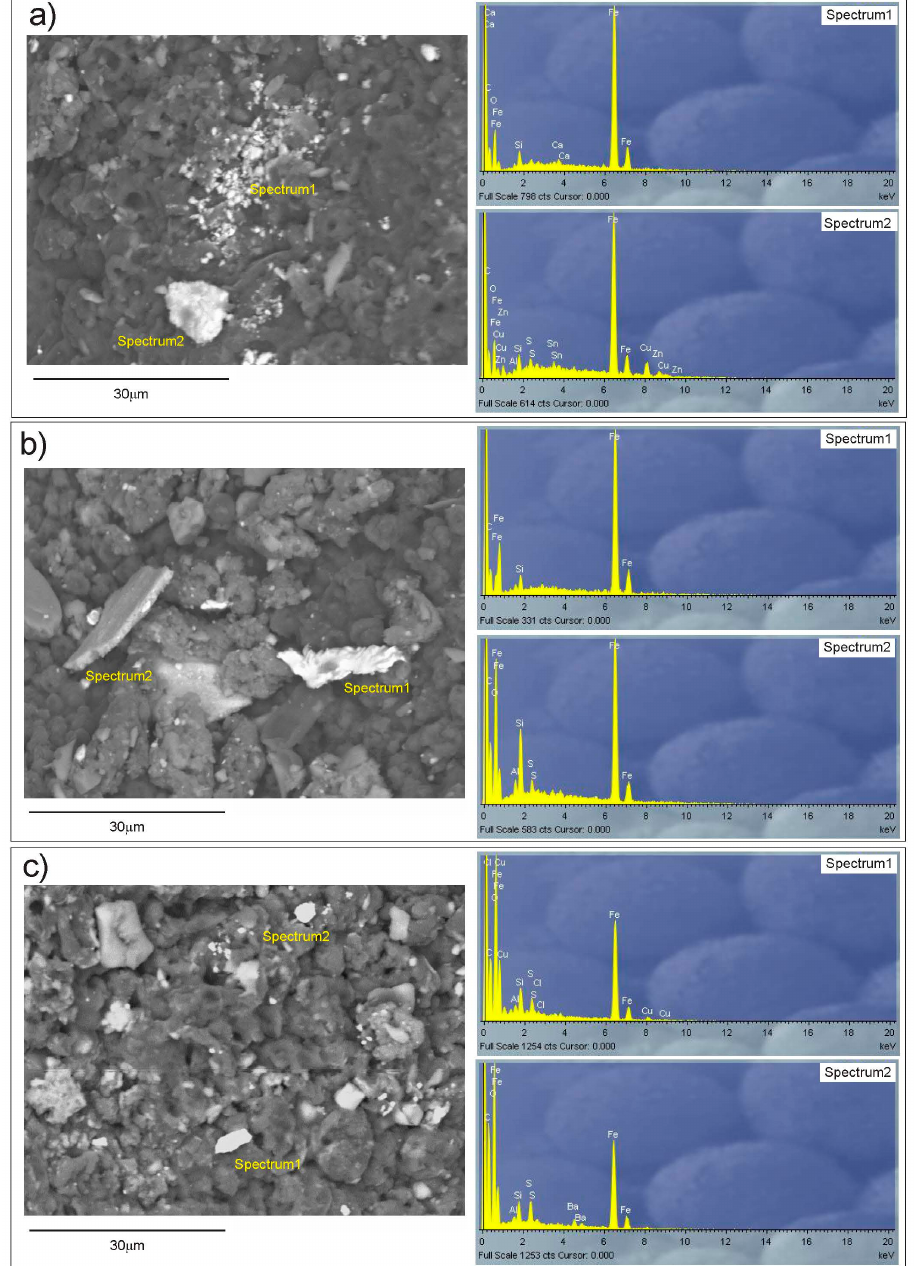
Figure 6. FESEM images and EDS spectra of selected particles embedded in the lichens exposed in Milan; ( a ) Spectrum 1; cluster of submicrometric Fe-rich particles; ( b ) coarse and flaky iron-rich residuals; ( c ) micrometric particles, rich in Fe, Cu and Ba.